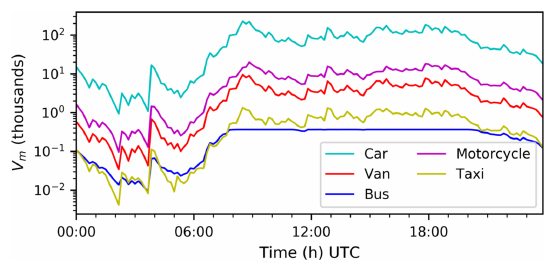
Figure 6. Simulated volume of vehicles across Greater London for 19 June 2015 (R5, Table 6).